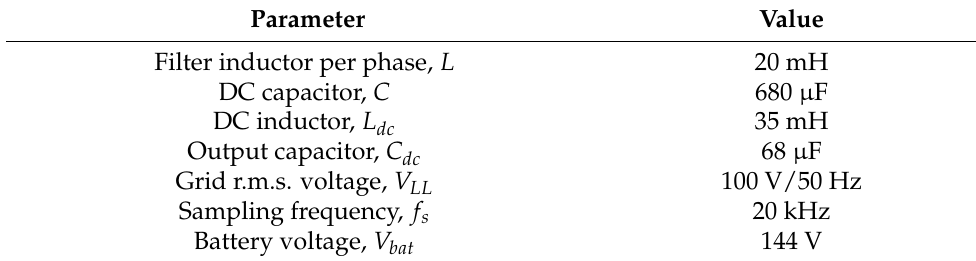
Figure 10. Experimental setup. Table 3. System parameters for the experimental